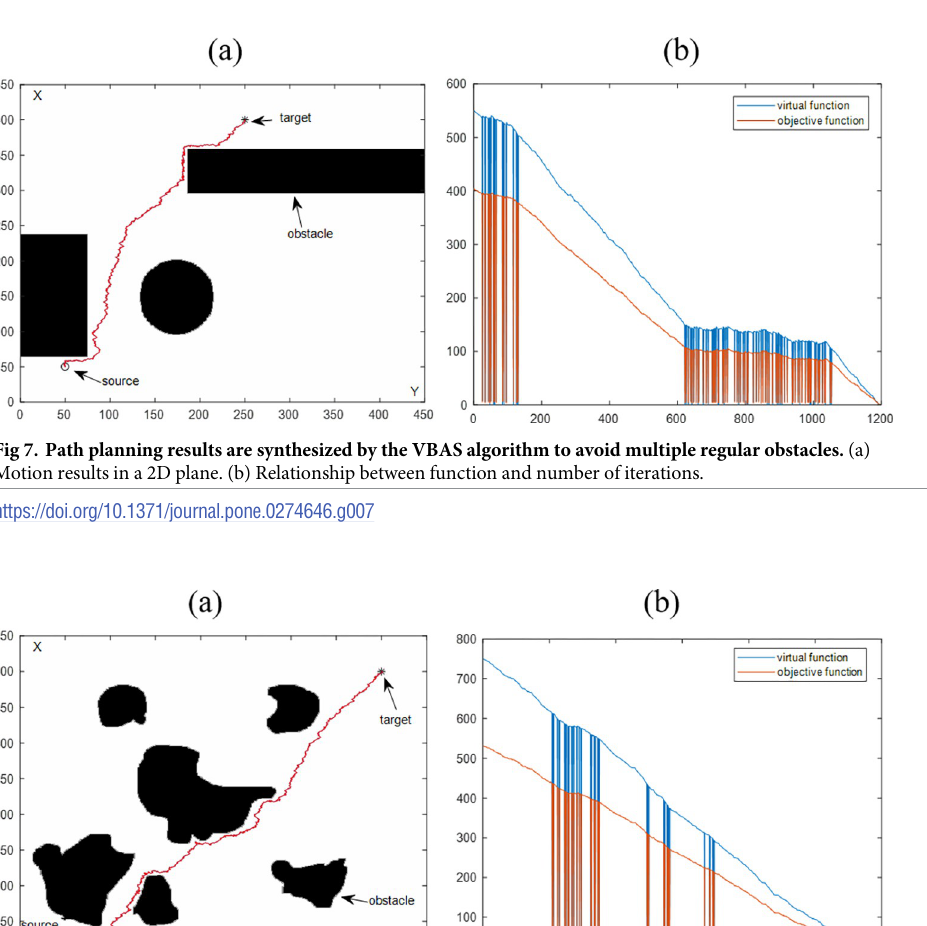
PLOS ONE | https://doi.org/10.1371/journal.pone.0274646 September 15,